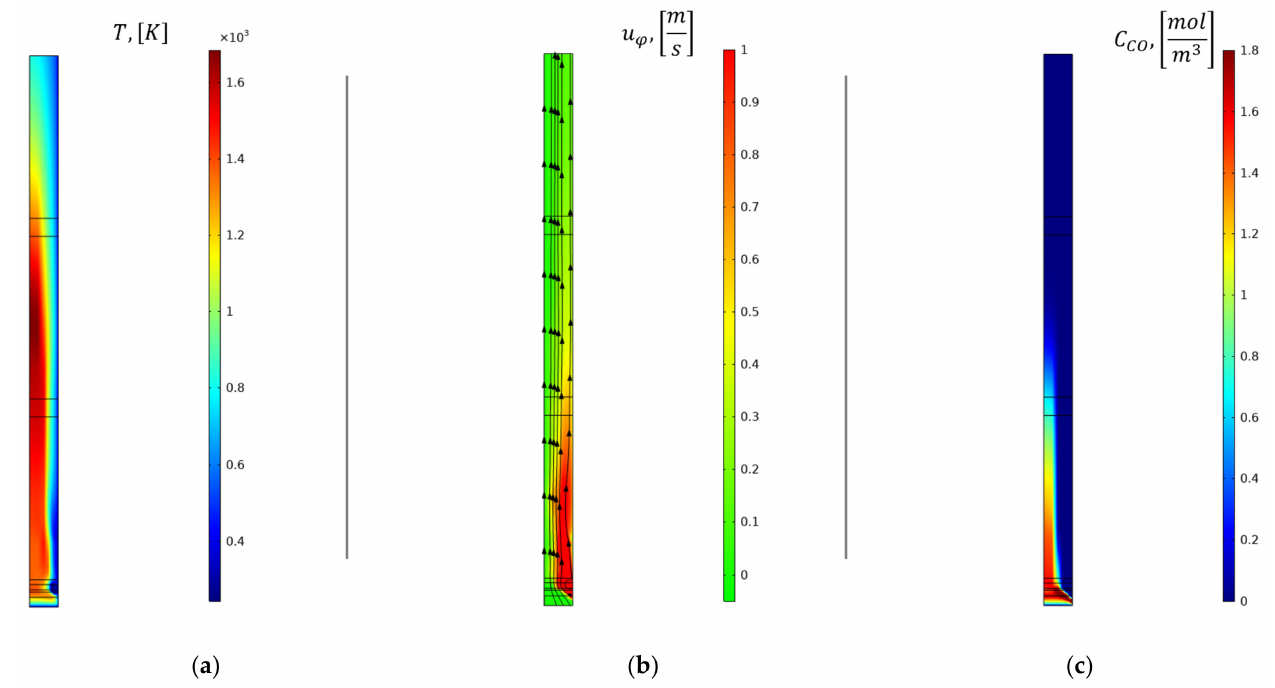
Figure 8. Distributions of fields when using raw straw pellets: ( a ) temperature, ( b ) velocity, ( c ) con- centration of CO.